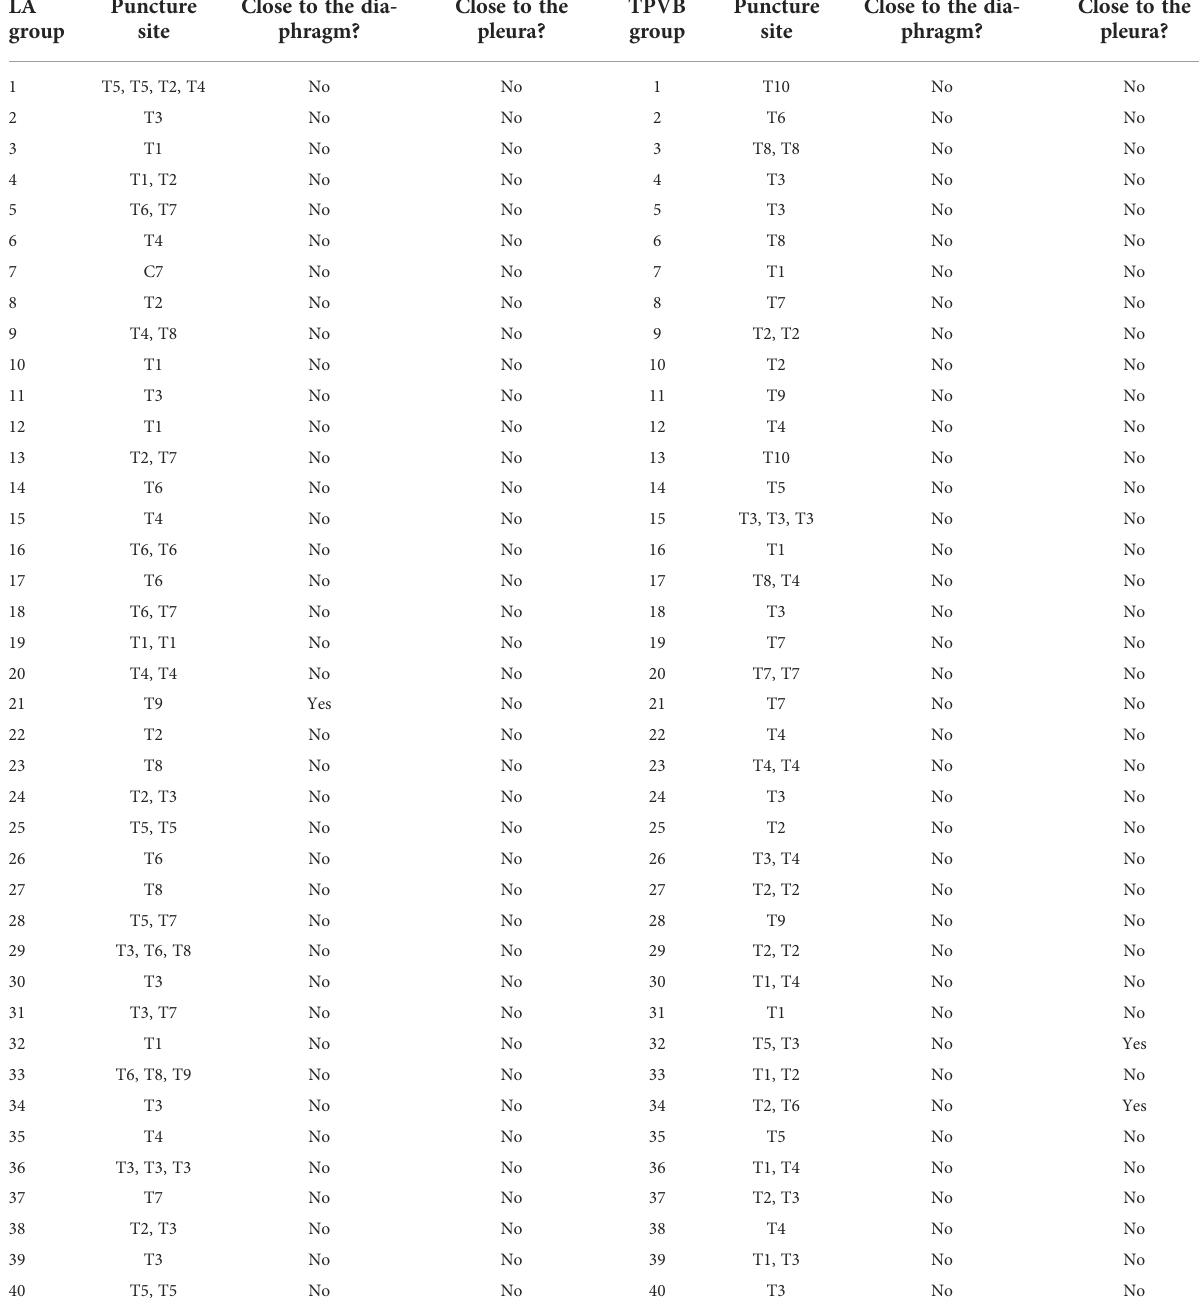
TABLE 4 Puncture sites and ablation sites close to the pleura or diaphragm. LA Puncture Close to the dia- group site phragm?